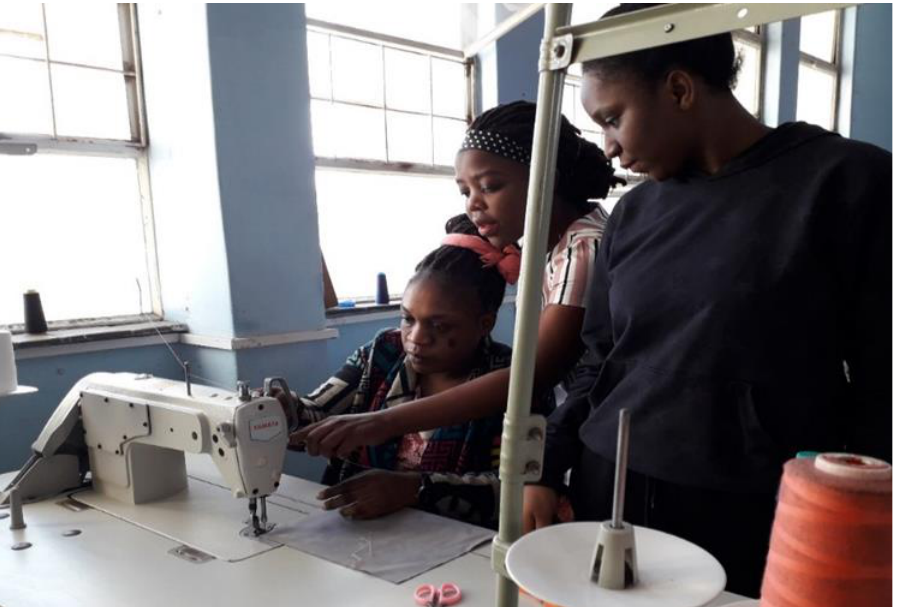
Figure 3 : Participants who joined earlier showing a new participant how to thread the sewing machine. Photograph taken by K.